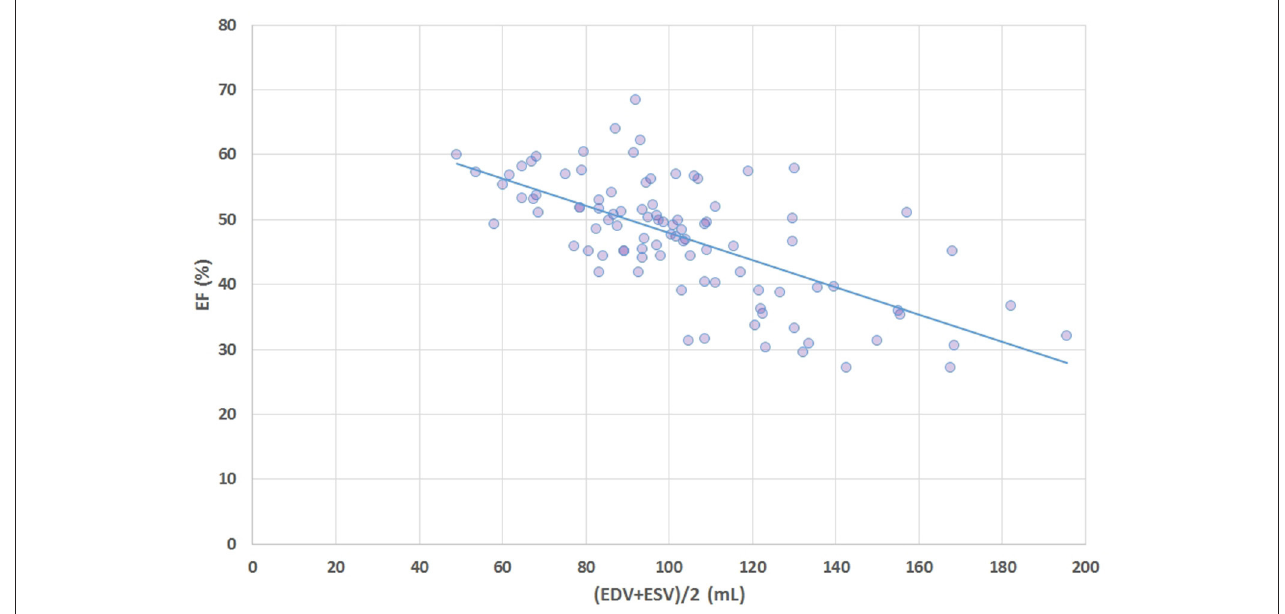
FIGURE 6 | Scatter plot of ejection fraction (EF, %) vs. average volume i.e., (ESV EDV)/2 shows that a major component of the definition formula for LVGFI is actually + highly correlated (R 0.66) with EF. = − TABLE 2 | Comparison of primary data (ESV, EDV, and LVmass) and their derivatives for the 3 diagnostic groups. AMI Myocarditis Takotsubo P(AMI vs. M) P(AMI vs. TCM) P(M vs.